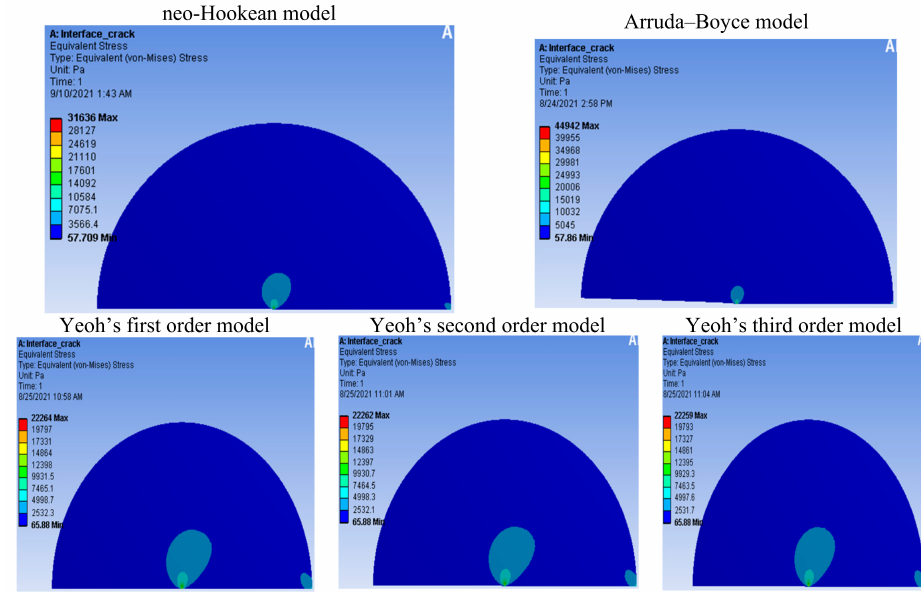
Figure 8. Distribution of the von Mises stress (Pa) during crack propagation. Diagrams of the variation in the normal deformation according to the crack